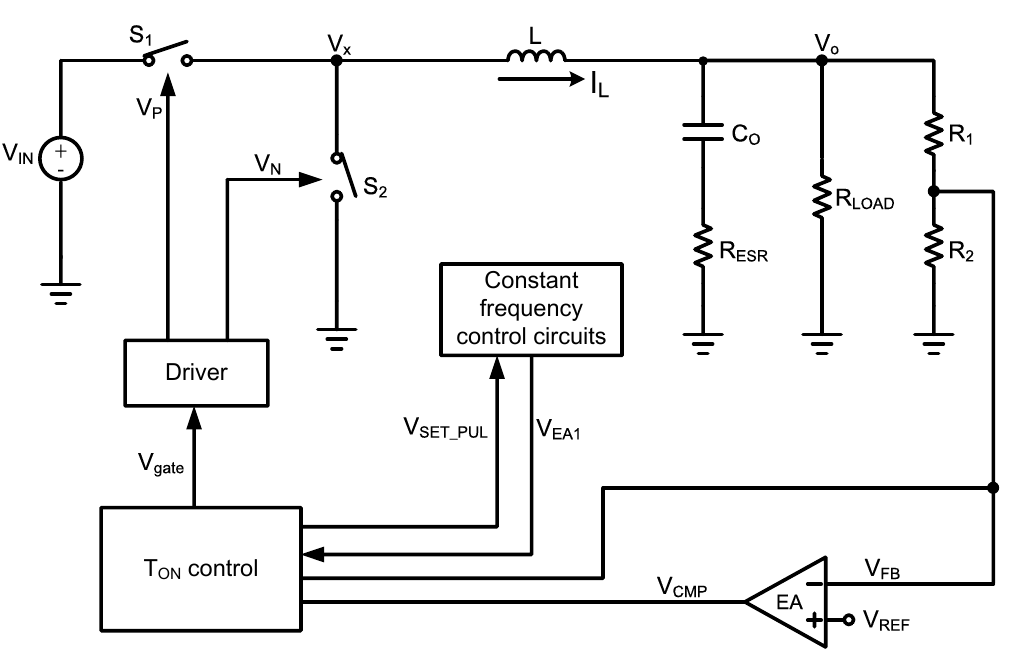
Figure 2. Dual loops control topology for buck converters.